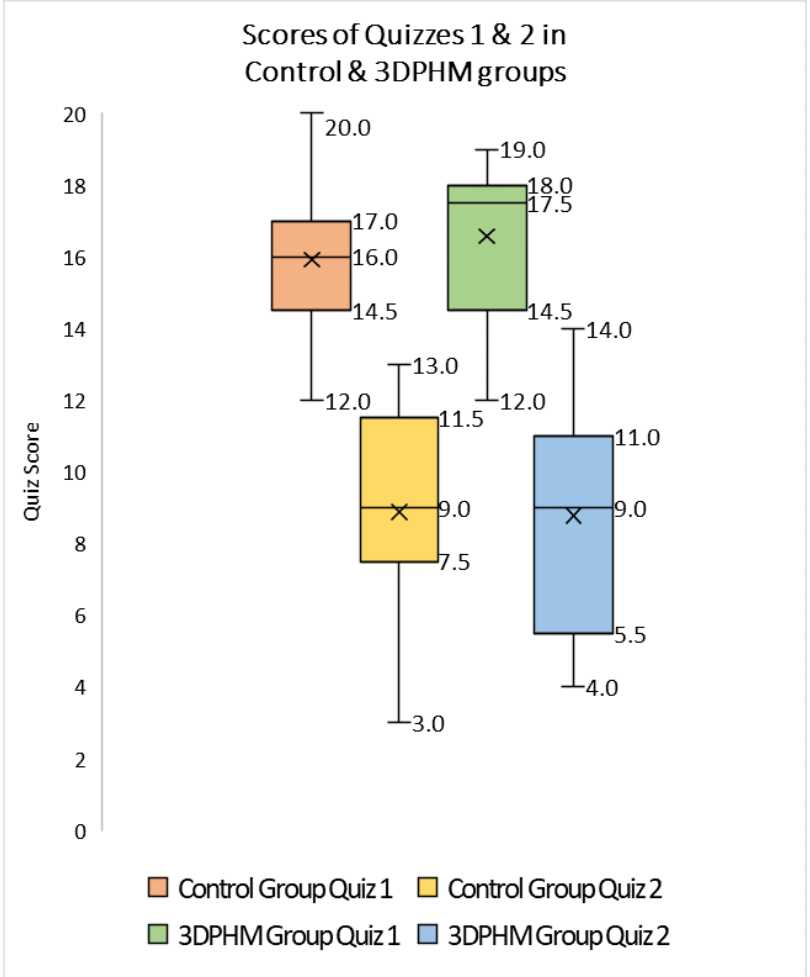
Figure 7. Boxplot of the scores (out of 20) achieved by 3D printing and control groups in Quiz 1 and Quiz 2. 3DPHM—3D-printed heart model. Reprinted with permission under open access from Lau and Sun [49].